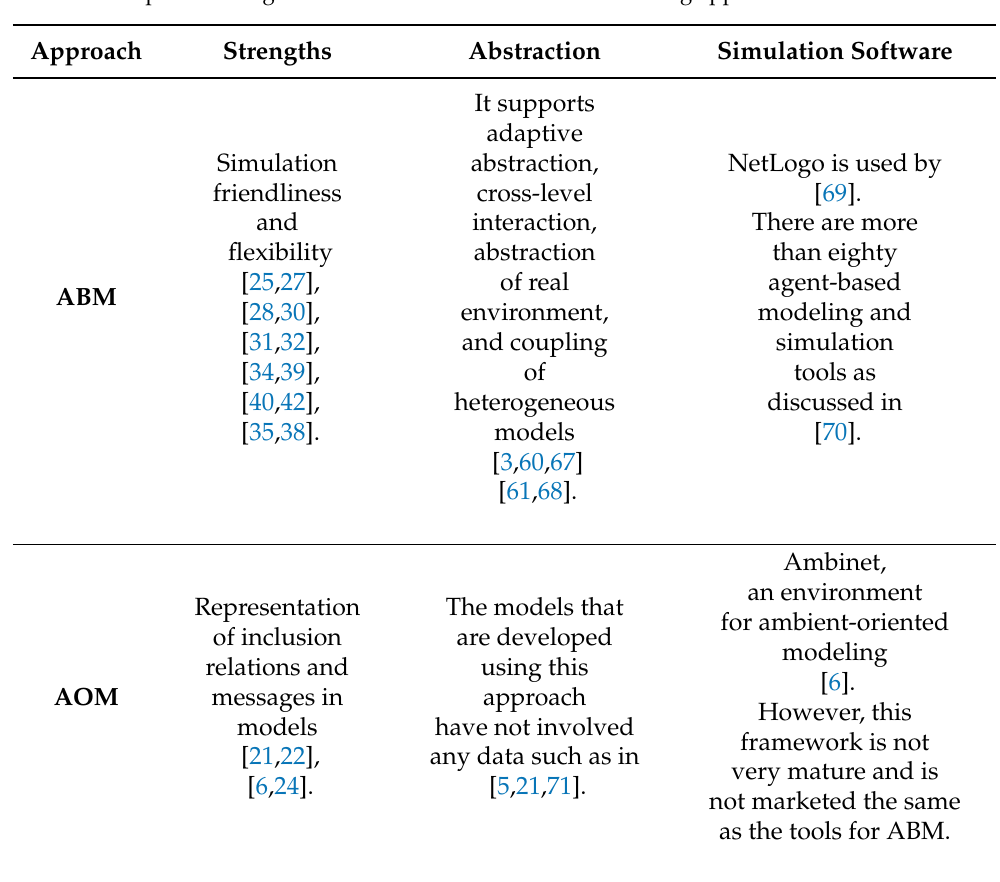
Table 1. Comparison of agent-based and ambient-oriented modeling